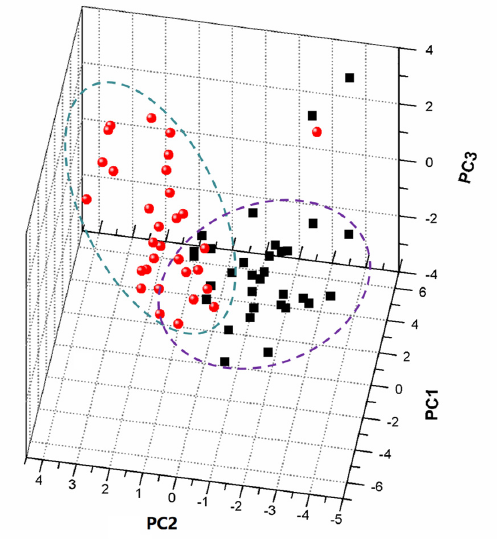
Figure 4. PCA score scatter plot of the 1 H NMR data of CMTP and CWTP samples. The ellipse in scores represents the Hoteling T2 with 95% confidence.